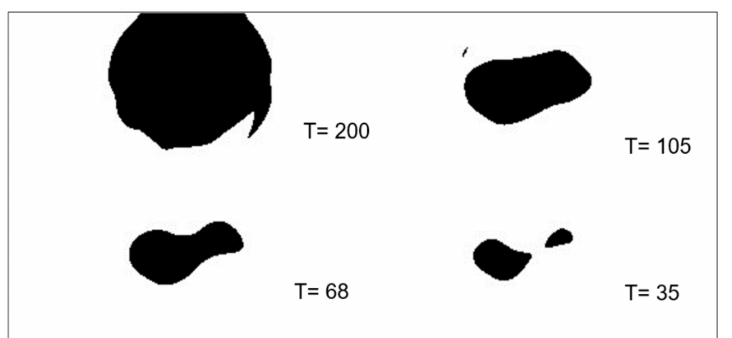
Figure 9. Example of the conversion of images (Sample 3) into a binary image using four differing thresholds but a constant averaging of 5, where T is the